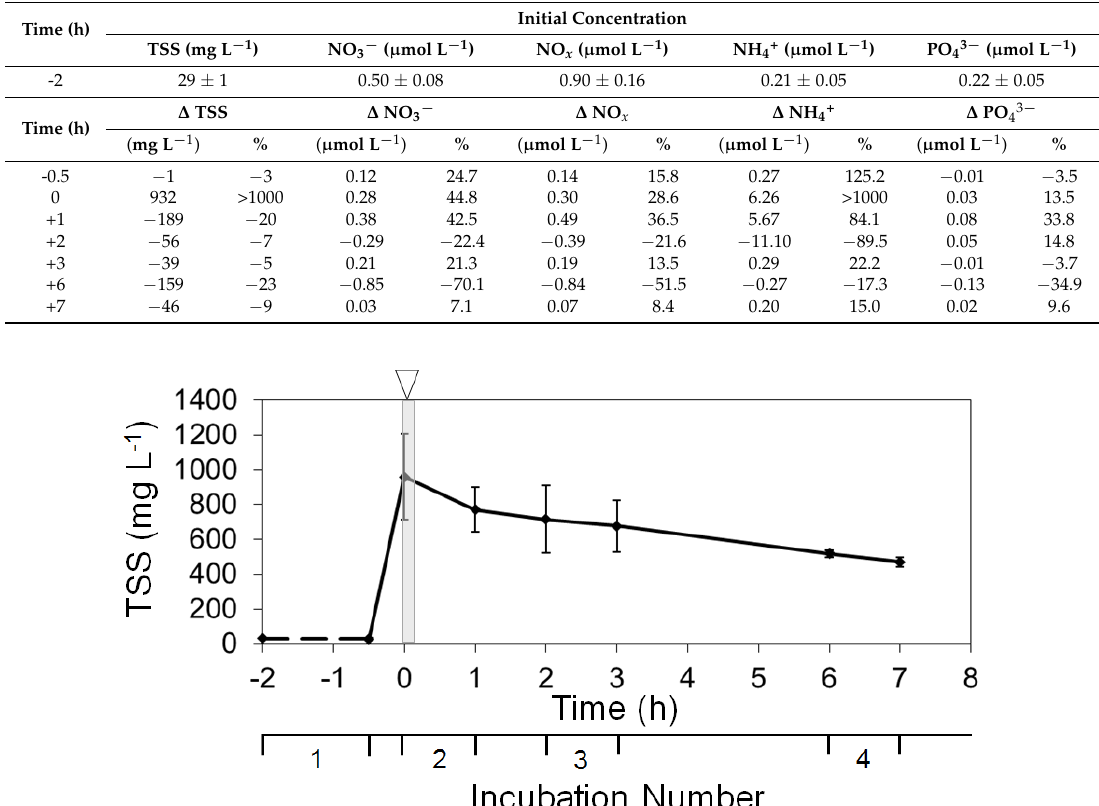
Figure 2. Total suspended solid concentrations during core incubations. The occurrence of the sediment disturbance and resuspension event is represented by ▽ and shading.